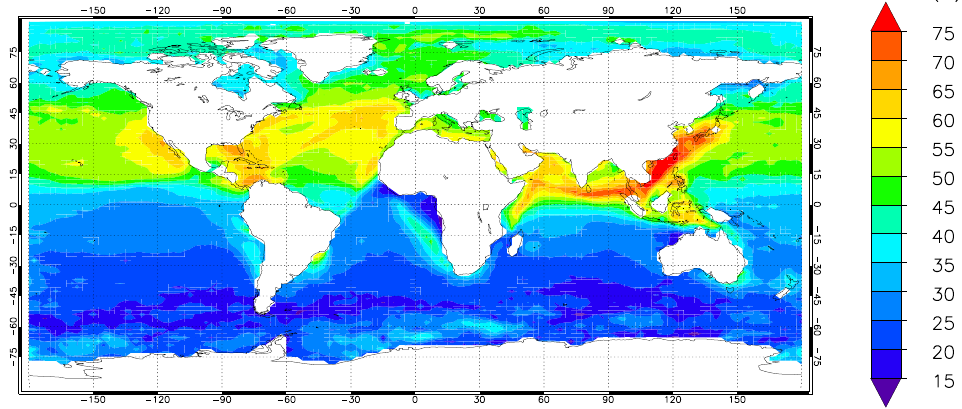
Figure 4. Anthropogenic influence upon the oceanic emission of inorganic iodine. The figure presents the percentage change of the ISG fluxes since pre-industrial times. The annual oceanic flux of ISG for the PD run is shown in Fig. 2.